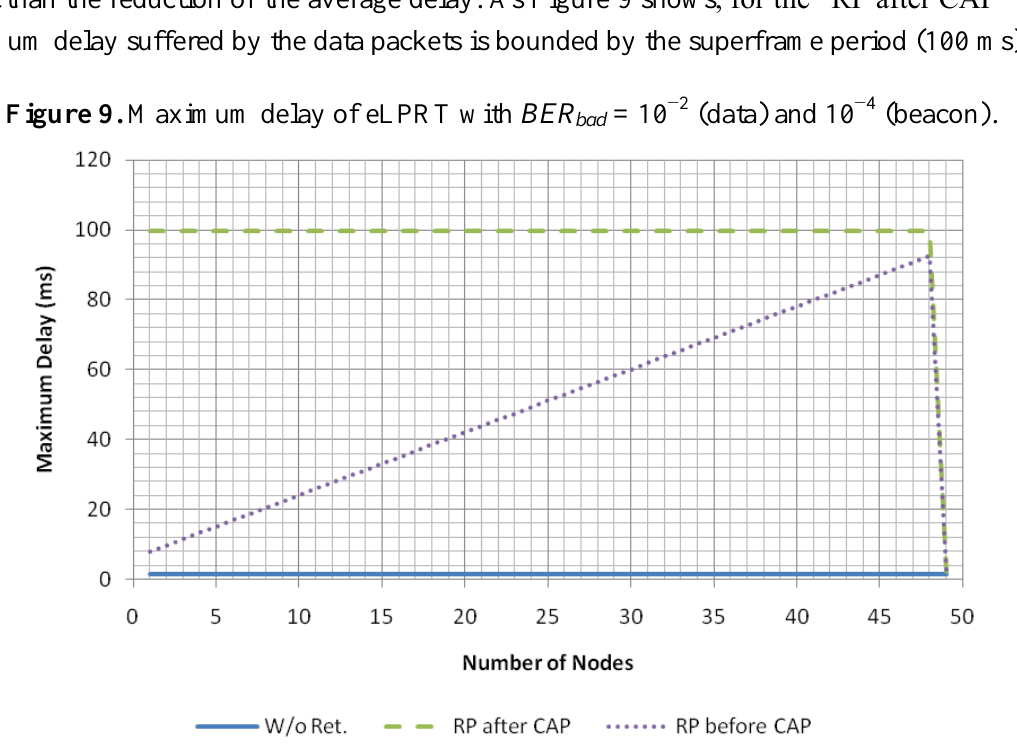
Figure 10. Current consumption of eLPRT with BER